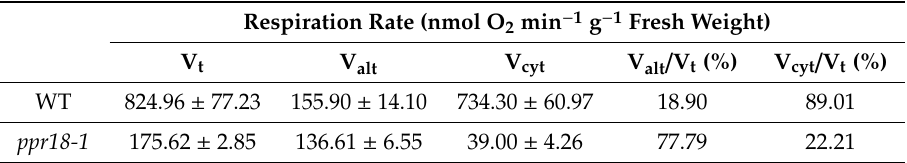
Table 1. Alteration of the respiration rate of the wild type (WT) and ppr18-1 kernels.